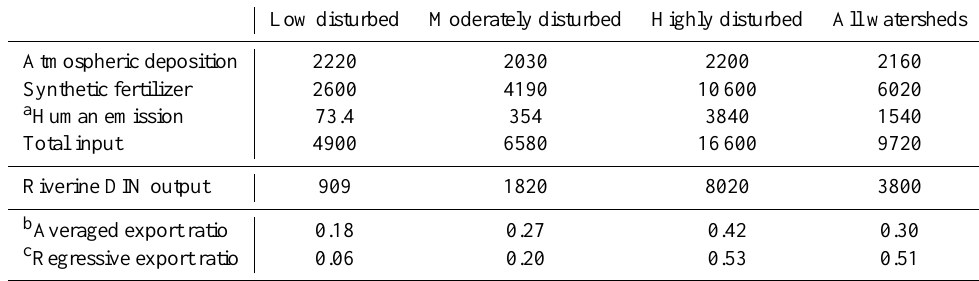
Table 5. Nitrogen inputs, riverine output, and riverine export ratios of the three categories of watersheds. Low disturbed